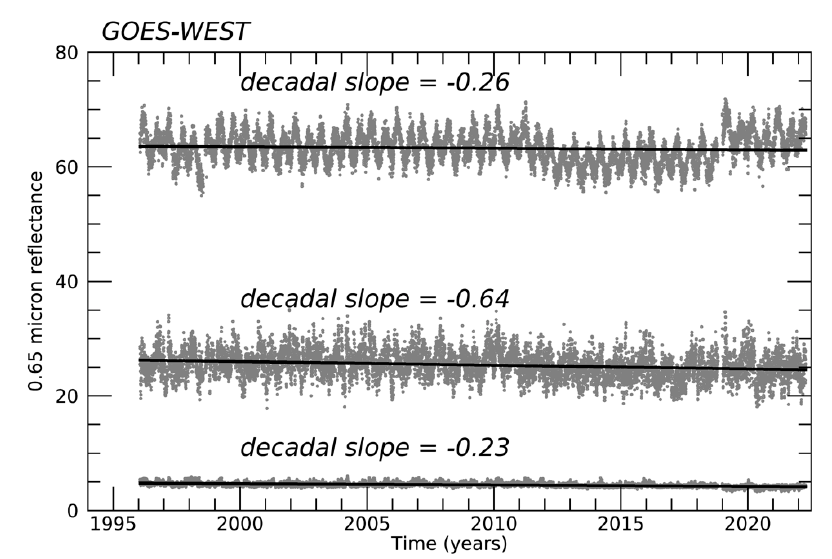
Figure 10. Same as Figure 9, except for GOES-West.